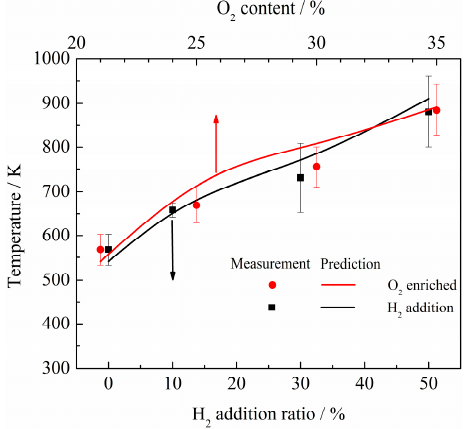
Figure 2. Comparison of predication temperature (line) and measurement temperature (plot) at the outlet of BG-2/air flames with various H 2 addition ratios ( black line ) and O 2 enrichment levels ( red line ).